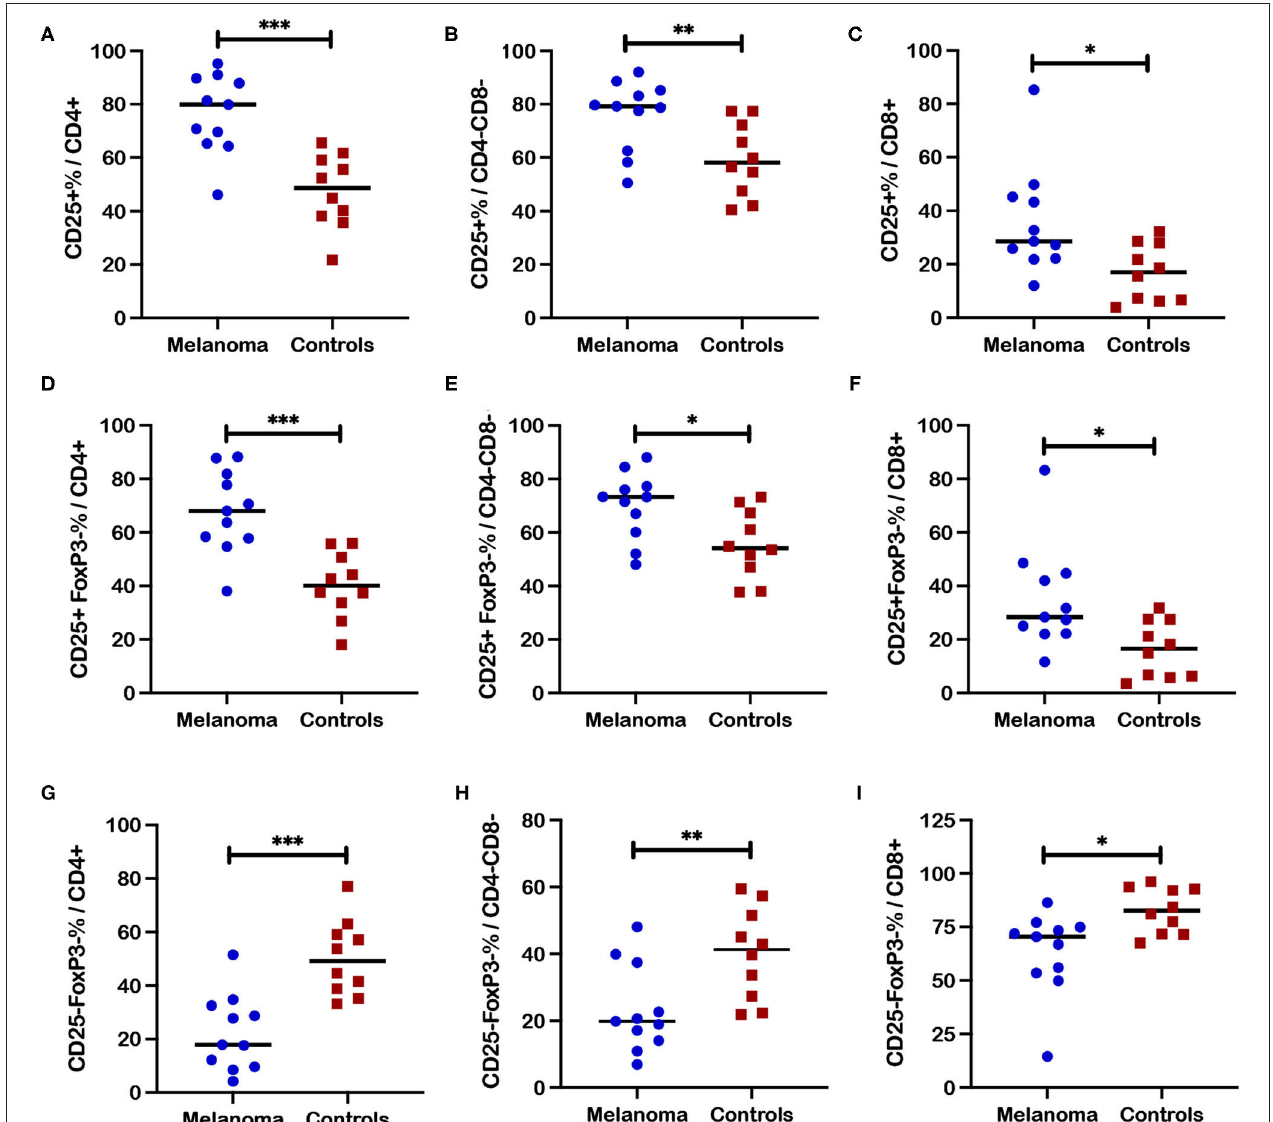
FIGURE 6 | Frequencies of CD25 + T cell subsets after ConA stimulation in blood from canine melanoma patients and healthy controls. Median frequencies of CD25 + cells after ConA stimulation were determined in (A) CD4 + , (B) CD4-CD8-, and (C) CD8 + T cells and compared between patients and healthy controls. Median cell frequencies after ConA stimulation are next shown for the activated phenotype CD25 + FoxP3- within (D) CD4 + , (E) CD4-CD8-, and (F) CD8 + T cells and compared between patients and controls. Median cell frequencies after ConA stimulation are shown for T cell phenotype CD25-FoxP3- within (G) CD4 + , (H) CD4-CD8-, and (I) CD8 + T cell populations and compared between patients and controls. Values described for CD25 + frequencies do not reflect subtraction of values for unstimulated cells. Pair-wise analysis between patients and controls was conducted with the Mann Whitney test using GraphPad Prism software and two-tailed analysis. A single asterisk (*) denotes a P -value < 0.05; two asterisks (**) denote a P -value < 0.01; and three asterisks (***) denote a P -value < 0.001. P -values < 0.05 are considered